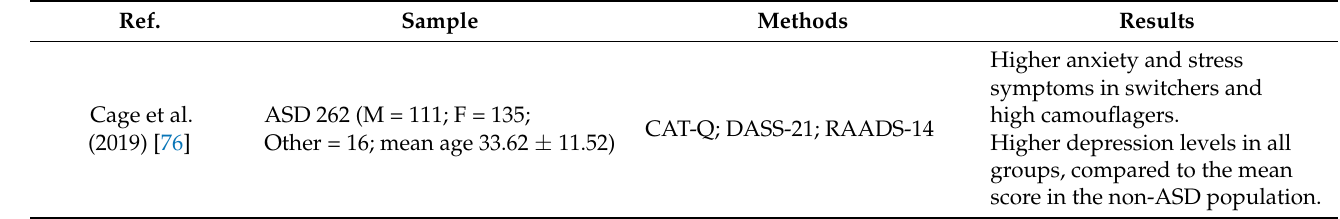
Table 4. The available literature on Social Camouflaging (Part